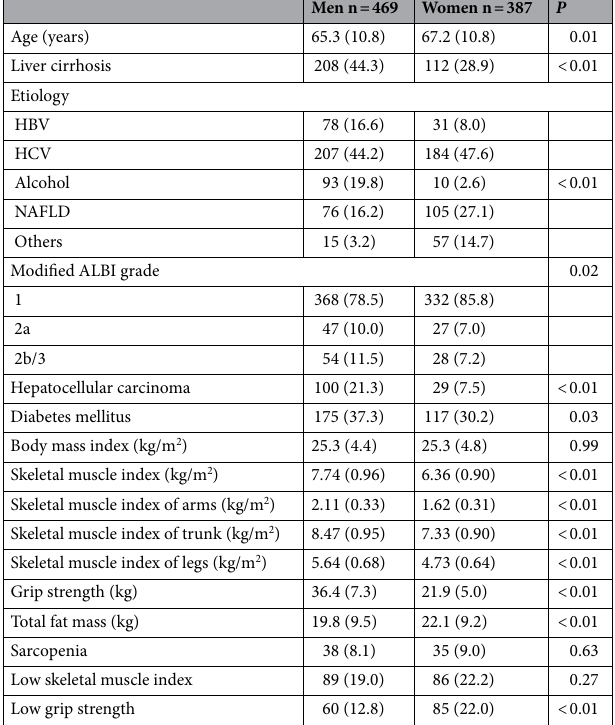
Table 1. Baseline characteristics. Values are presented as the mean (SD) or number (%). ALBI, albumin- bilirubin; HBV, hepatitis B virus; HCV, hepatitis C virus; NAFLD, nonalcoholic fatty liver